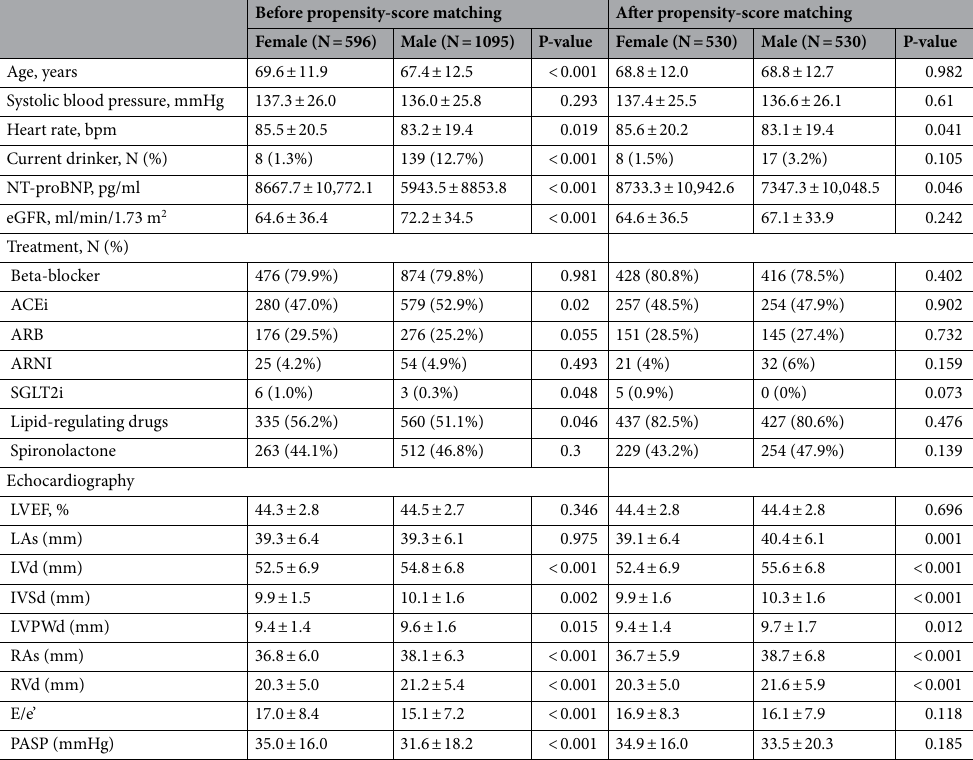
Table 2. Baseline characteristics not participating in PSMA matching. Values are mean ± SD or %. PSMA propensity score-matched analysis, NT-proBNP N-terminal pro-B type natriureti peptide, eGFR estimated